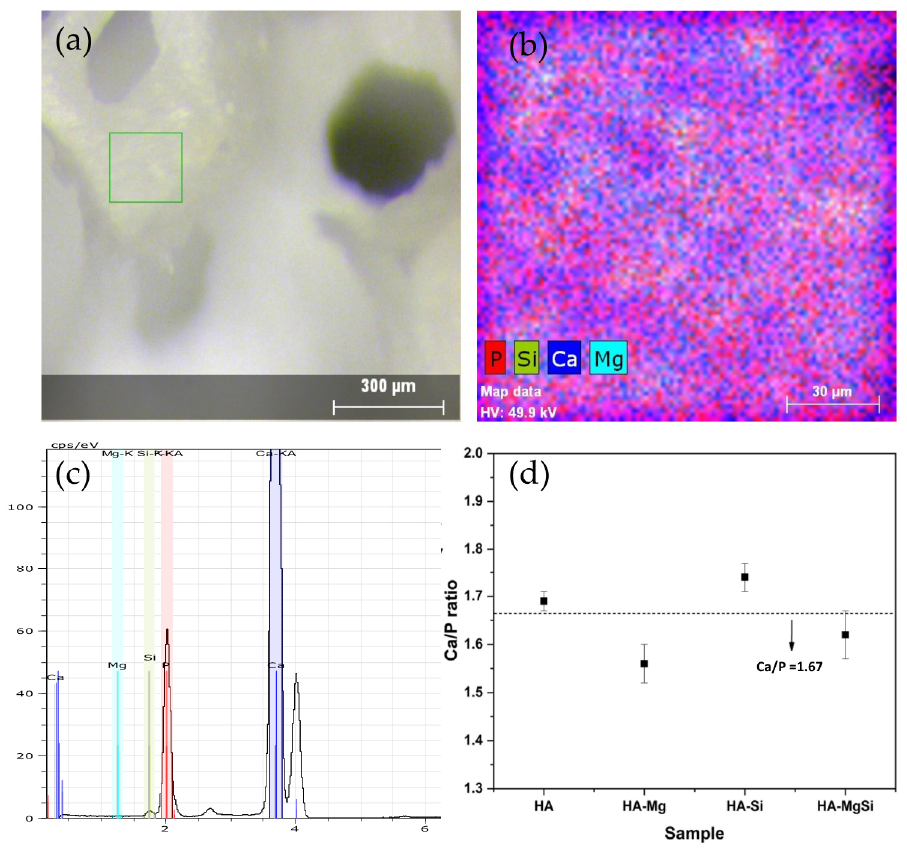
Figure 3. Optical image of mapped zone ( a ), elemental mapping ( b ) XRF spectra of HA-MgSi scaffold ( c ) and plot of Ca/P ratio of all scaffolds obtained from XRF data ( d ). Table 2. Linear shrinkage, apparent density, porosity, pore size ranges and grain size of synthe- sized